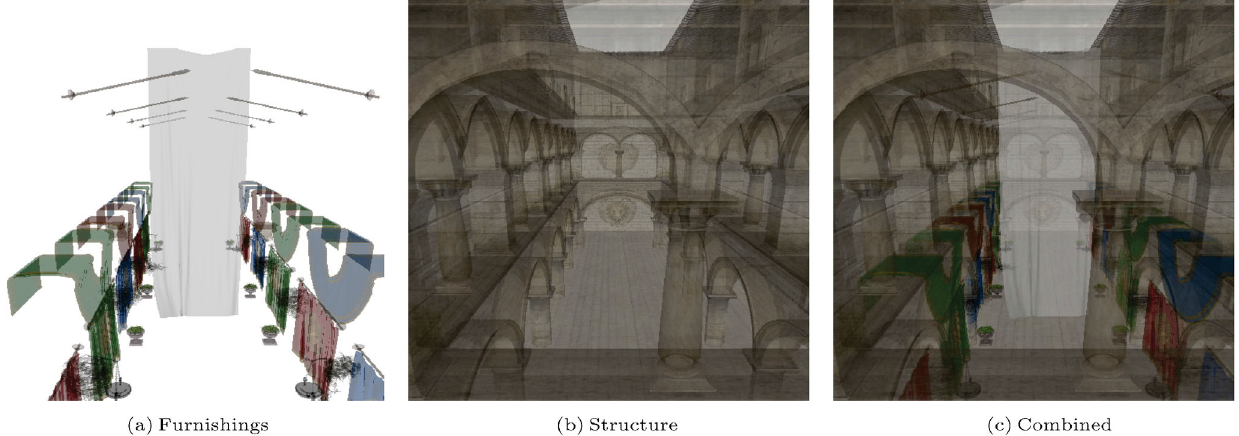
Fig. 1 Merged interior and exterior Atrium deep